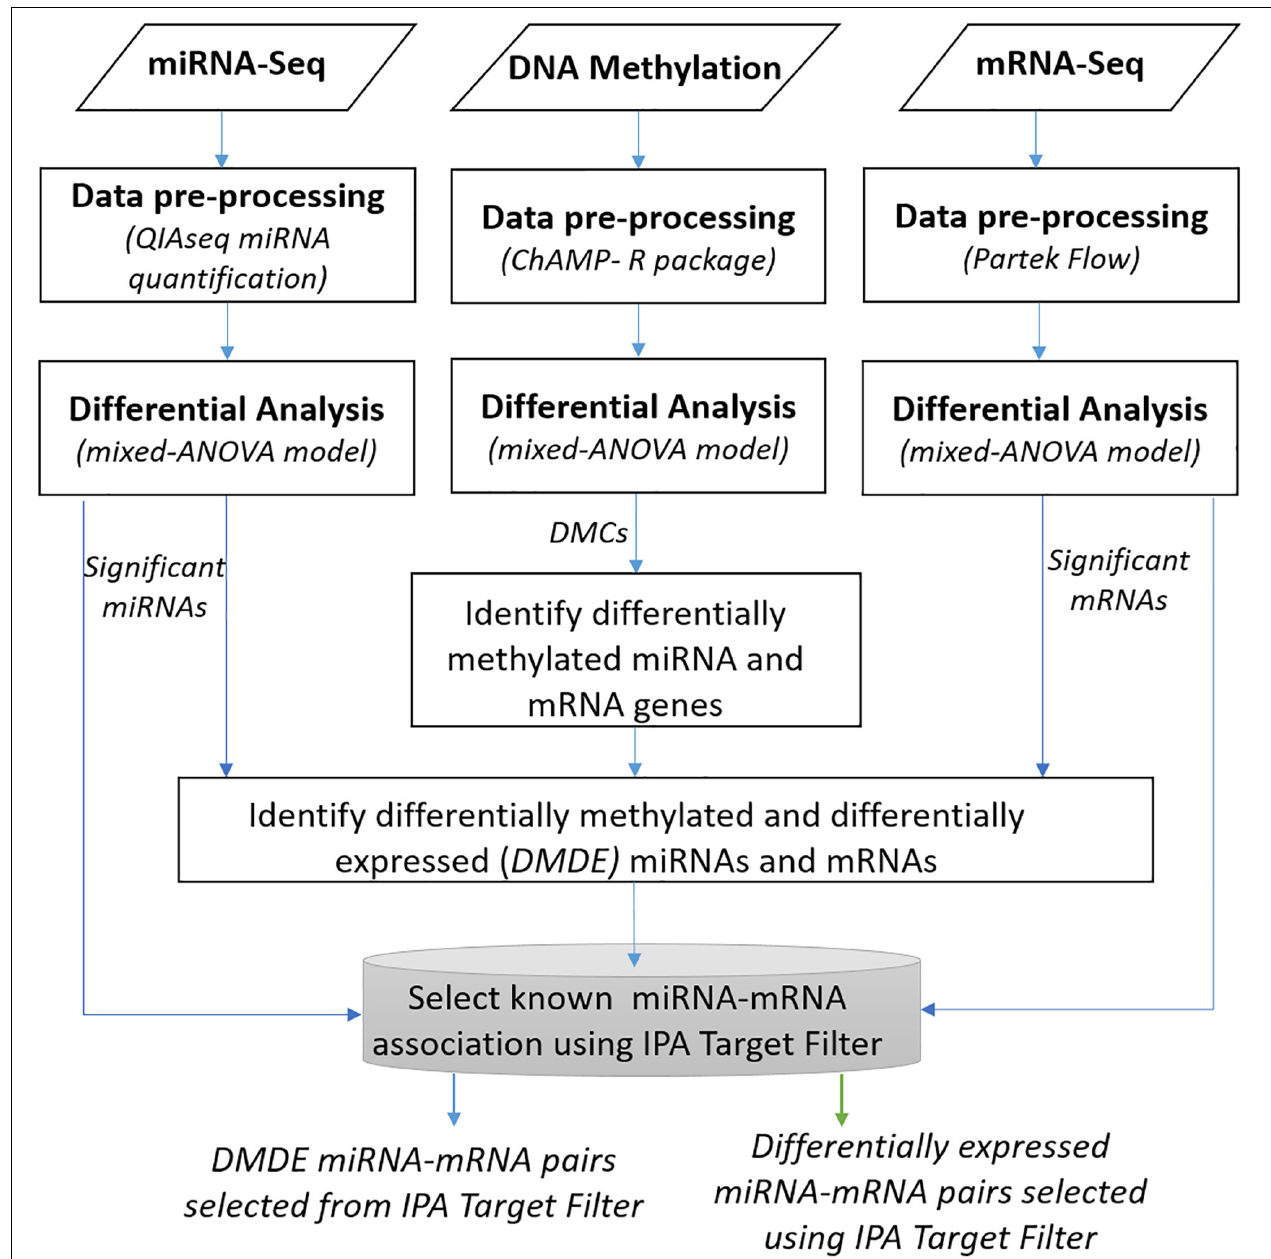
FIGURE 1 | Overview of integrative analysis of multi-omic data.